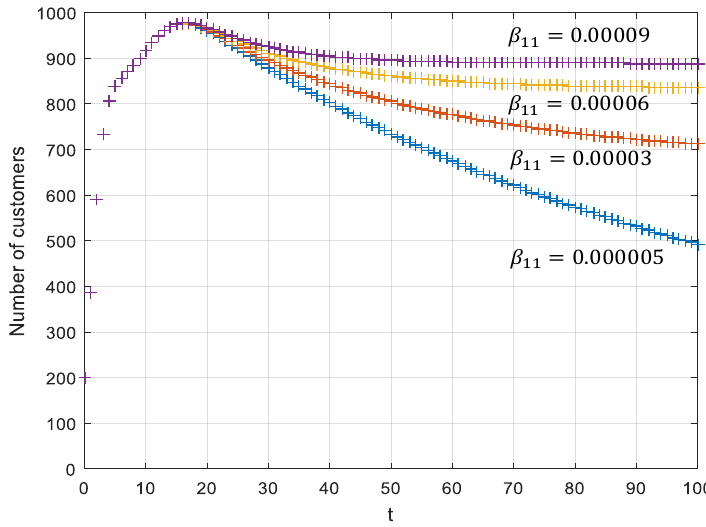
Figure 6. Total sales volumes for the dual-channel supply chain for di ff erent β 11